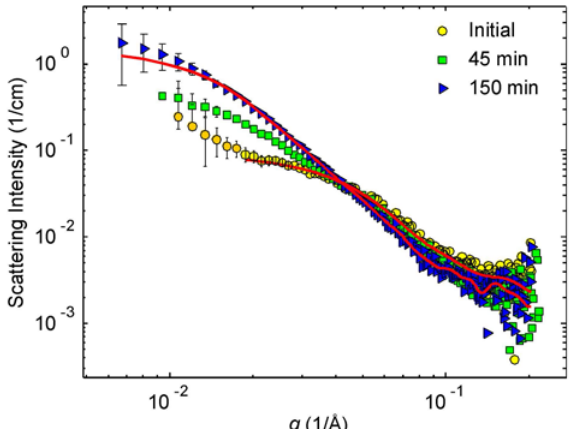
Figure 3. SAXS patterns from initial (yellow circles), 45 min (green squares) and 150 min solutions (blue triangles). Solid lines are the corresponding GNOM fits (see Section 3 for details).